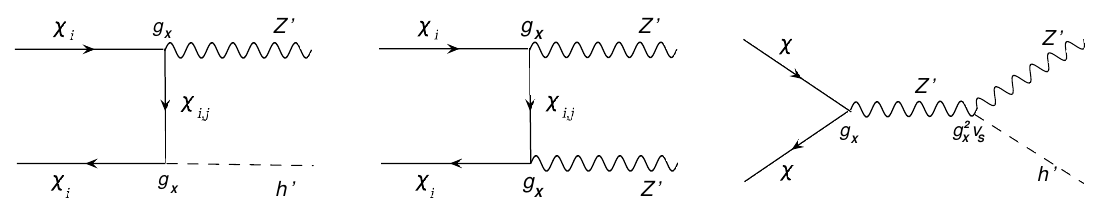
Figure 4. Example of early-Universe annihilation diagrams for highly-mixed Z 0 -ino/singlino neu- tralinos, yielding to (cid:12)nal states dominated by the h 0 and Z 0 bosons. for m (cid:25) 1 TeV. A spin independent cross section of this size corresponds to a typical (cid:31) gaugino mass of about 2 : 5 (cid:0) 3 TeV. For recent reviews of the typical direct and indirect